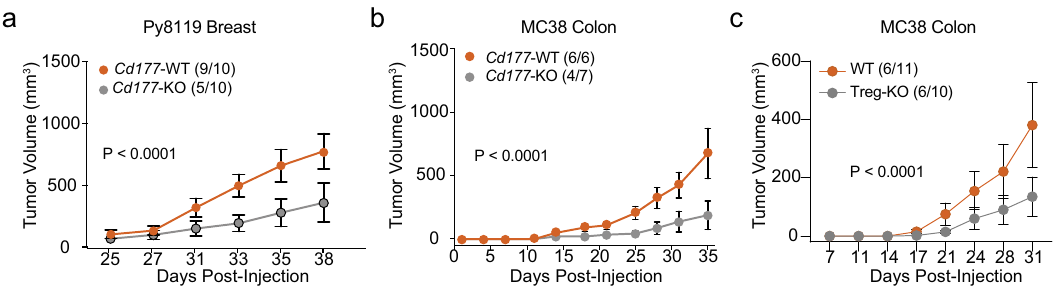
Fig. 5 Cd177 -de fi ciency in Treg cells leads to reduced tumorigenesis. a Py8119 tumor growth is signi fi cantly reduced in Cd177- KO mice compared to WT, P < 0.0001 in female mice challenged with 5×10 2 cells per inoculation, n = 10 bilateral tumors. b MC38 tumor growth is signi fi cantly reduced in Cd177- KO mice compared to WT, P < 0.0001 in male mice challenged with 5×10 4 cells per inoculation ( n = 6 WT and 7 KO). c MC38 tumor growth is signi fi cantly reduced in Treg-speci fi c Cd177- KO ( Cd177 fl / fl /Foxp3-Cre) male mice compared to control male mice either carrying fl oxed Cd177 allele ( Cd177 fl / fl ) or Cd177 fl / + /Foxp3-Cre . P < 0.0001 in mice challenged with 5×10 4 cells per inoculation ( n = 10 WT and 11 Treg-KO). a – c Numbers in parenthesis equates to